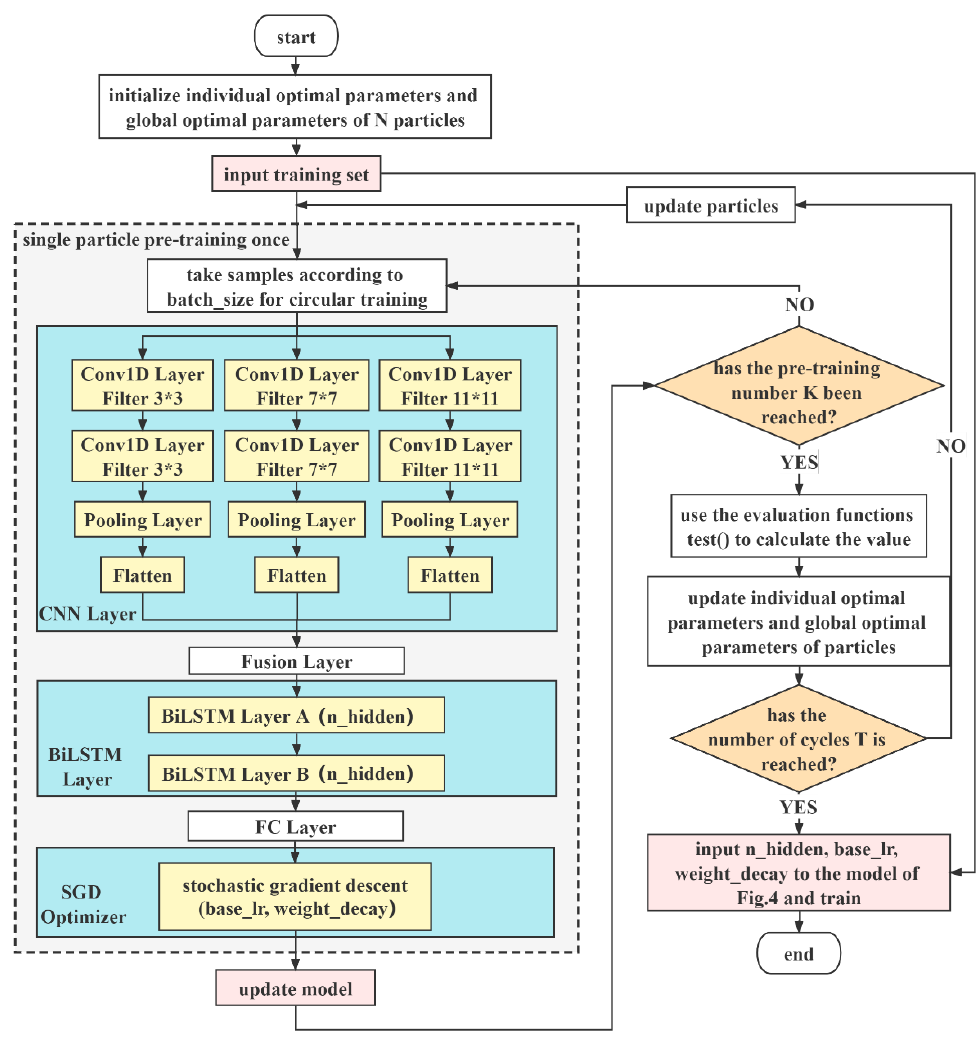
Figure 5. Algorithm flow chart. Algorithm 1. PSO-1DCNN-BiLSTM Algorithm.